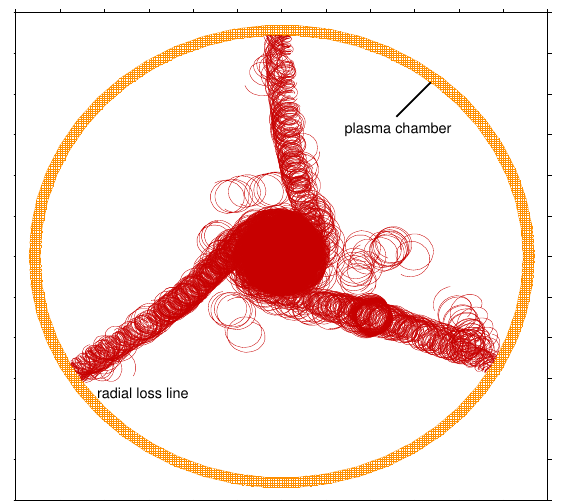
Figure 3. Ion trajectories (in red) within the plasma chamber (in orange), projected in the beam direction at 0.4m with a projection depth of 8mm. The ions gyrate along the magnetic field line. ± See Figure 5 to identify this location close to the plane of extraction. The three wings in the plane of the extraction aperture have their origin in the radial plasma loss lines. In this projection, they appear like three ρ -shape wings, shifted by